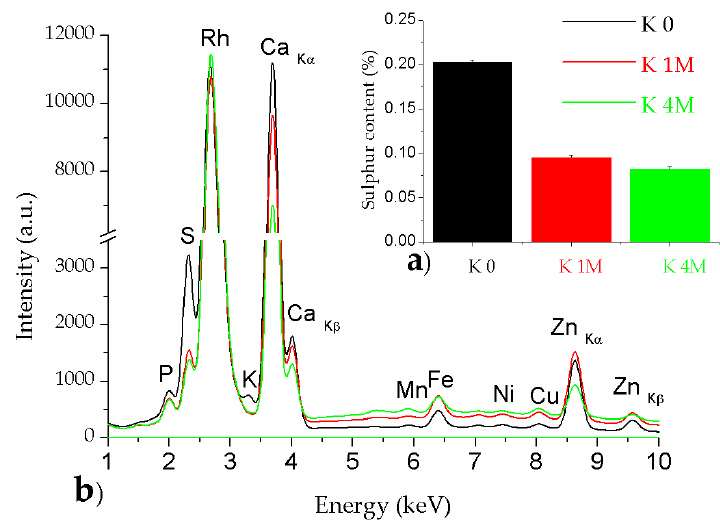
Figure 5. X-ray fluorescence (XRF) analyses: ( a ) sulfur content; ( b ) mineral content.